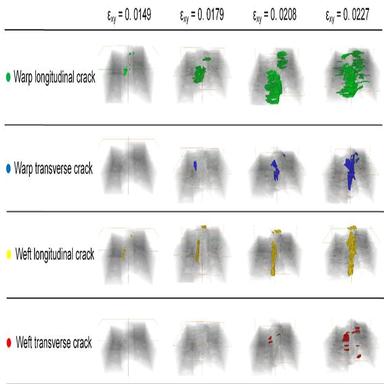
Crack marks at various stages of damage.